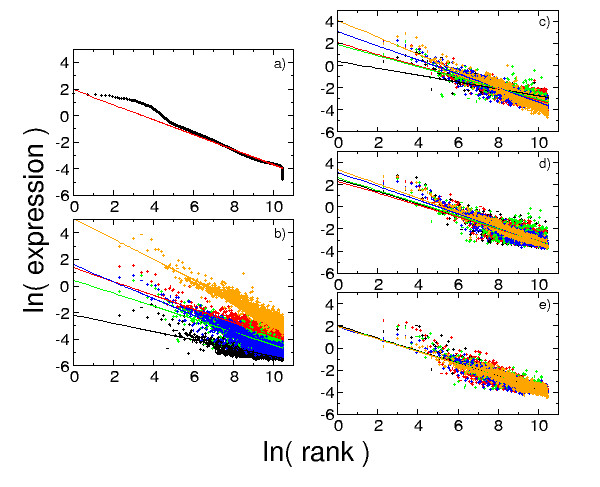
Unigene microarray log plots. Five human Unigene microarrays from the panel of thirty-one microarrays used in the sigmoidal colon experiments. Upper left to lower right: a. Loge median gene intensity vs. loge rank – conformity to Zipf's law is demonstrated by the linear regression line (in red) b. Five microarrays chosen to maximize pre-normalization variability, each plotted according to the gene ranks determined by their median gene intensity levels. c. The same five microarrays, normalized to a global mean, with regression lines. d. The same five microarrays, normalized with the quantile method, with regression lines. e. The same five microarrays, normalized taking Zipf's law into account, with regression lines. For plots b-d, a sub-sample of 10% of the data points are plotted for readability.